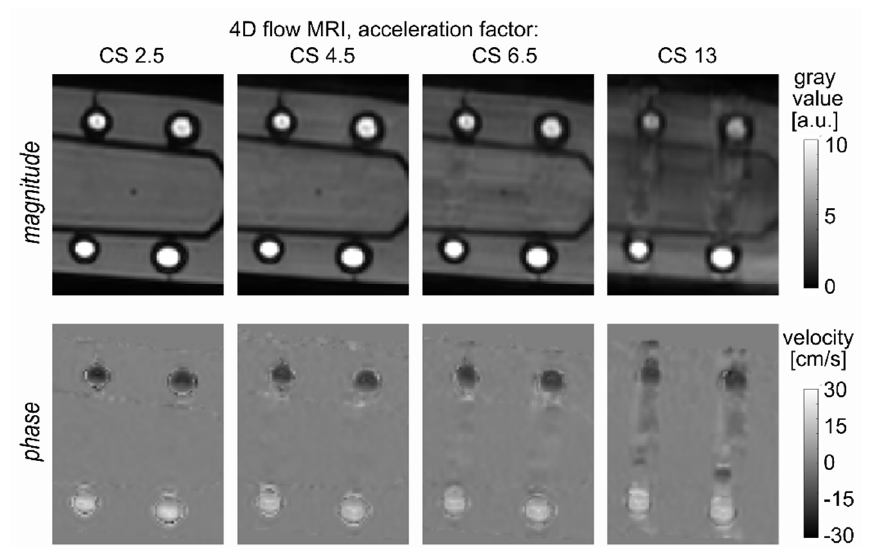
Figure 6. A representative cross-section of the silicone tubes with a diameter of 4 and 5 mm that were imaged with 4D flow MRI. The sequence was accelerated factors of 2.5-, 4.5-, 6.5-, and 13 (from left to right), and an isotropic voxel size of 1 mm 3 was used. Note the severe image distortion when an acceleration factor of 13 is applied. Phase image with velocity encoding in foot to head direction, which is collinear with a flow direction, is shown.